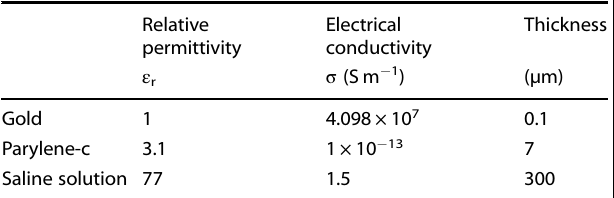
Table 1. Parameters used for the